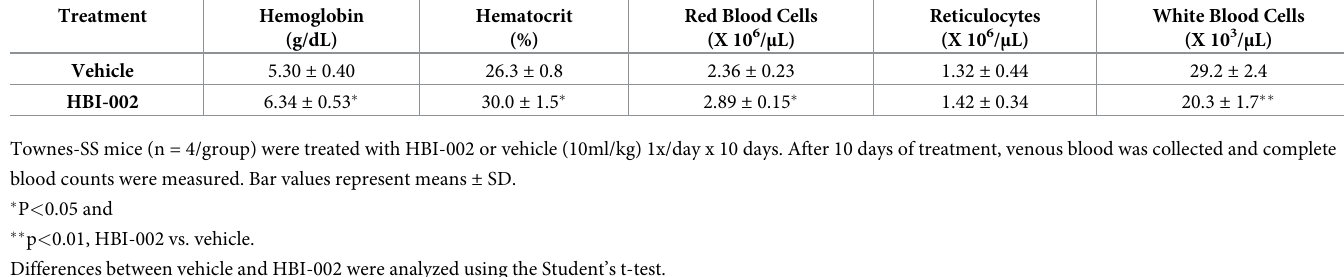
RBC counts without a significant change in the absolute reticulocyte counts ( Table 1 ) suggests that CO may have decreased the destruction rate of RBC in SS mice without increasing the production rate of RBC.